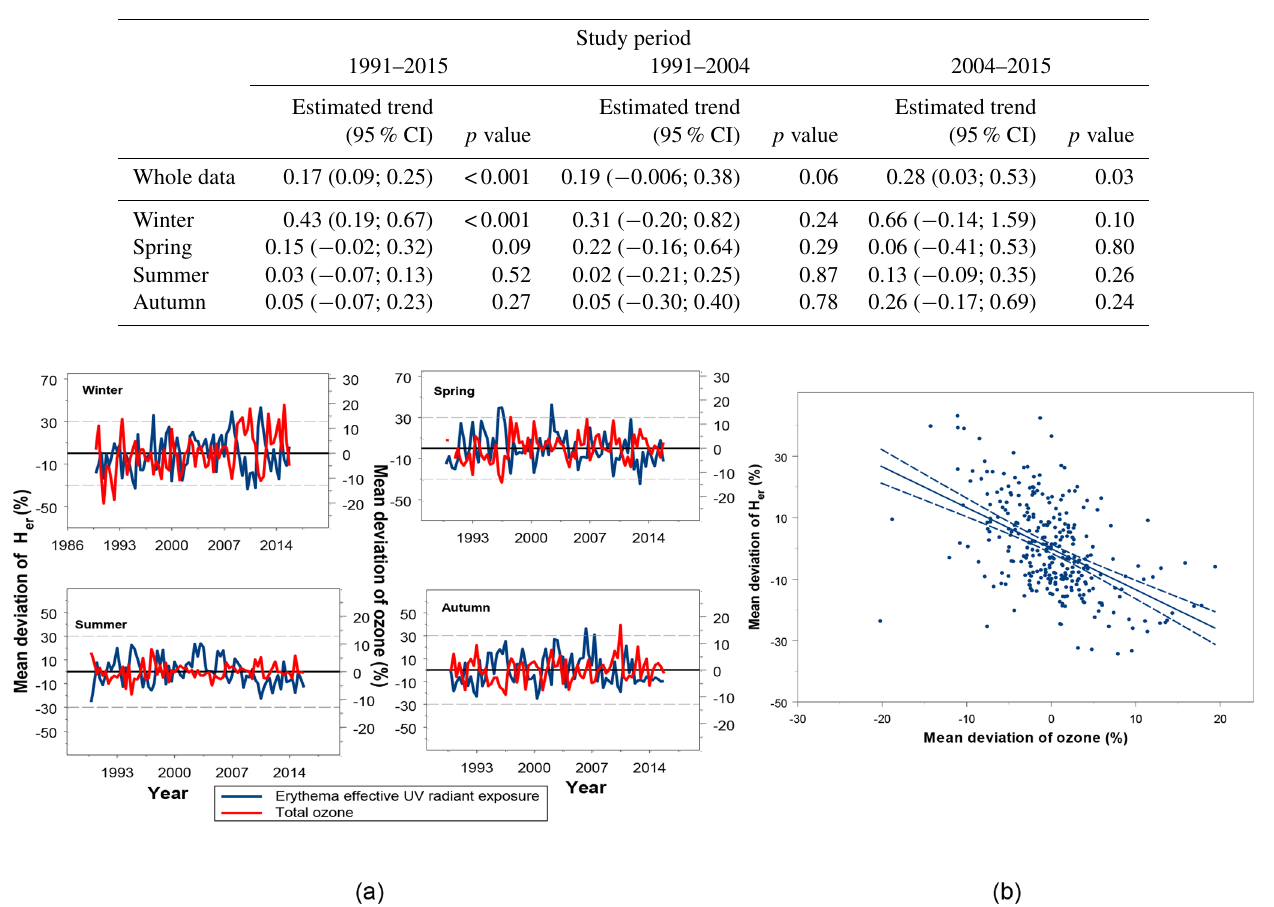
Figure 4. Relationship between monthly mean deviation of H er (1991–2015) and TO (1991–2015): (a) seasonal and (b) fitted linear regres- sion line with 95%